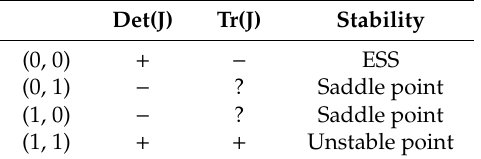
Table 4. Stability analysis of the points in case (1).